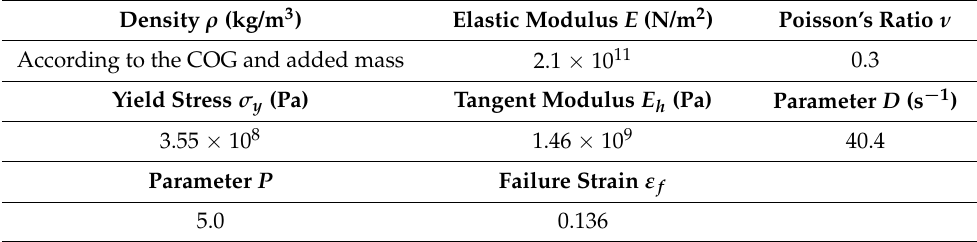
Table 6. The added mass coefficients of the supply ships and the platforms.